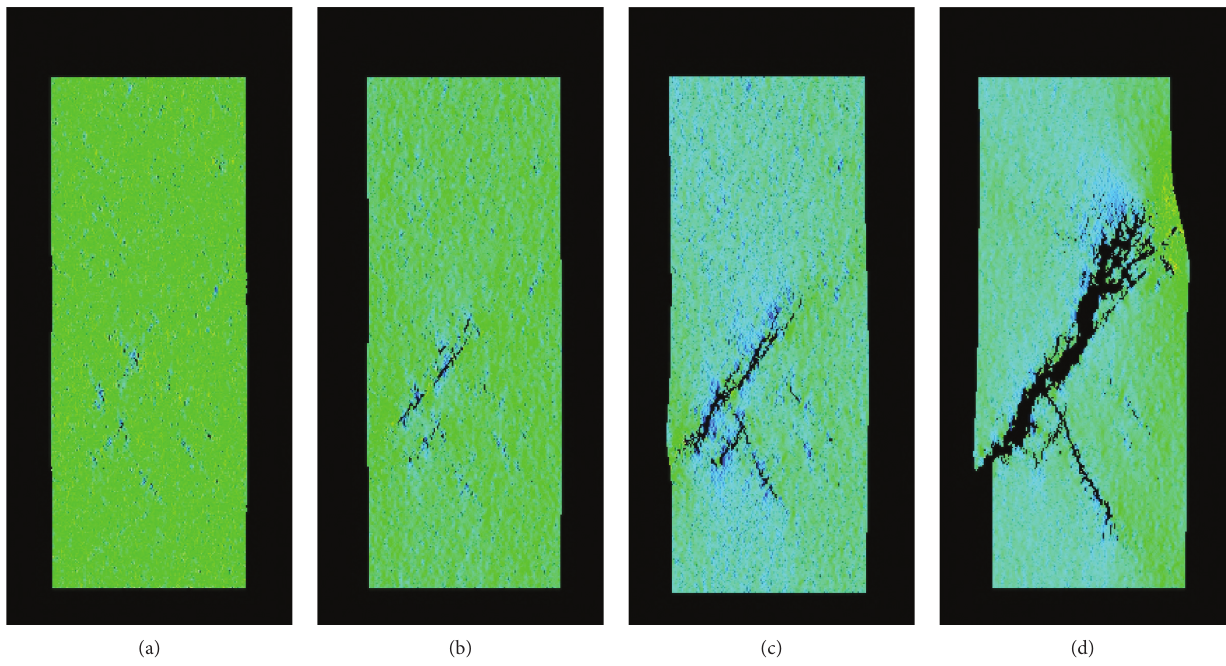
Figure 8: Macroscopic failure of rock mass at the height-to-diameter ratio of 3.